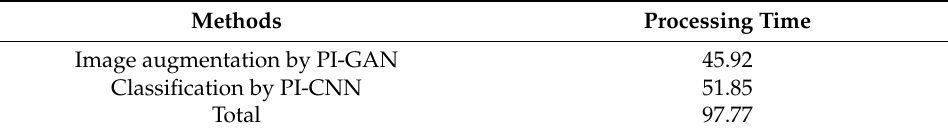
Table 34. Processing time of the methods per image (unit: